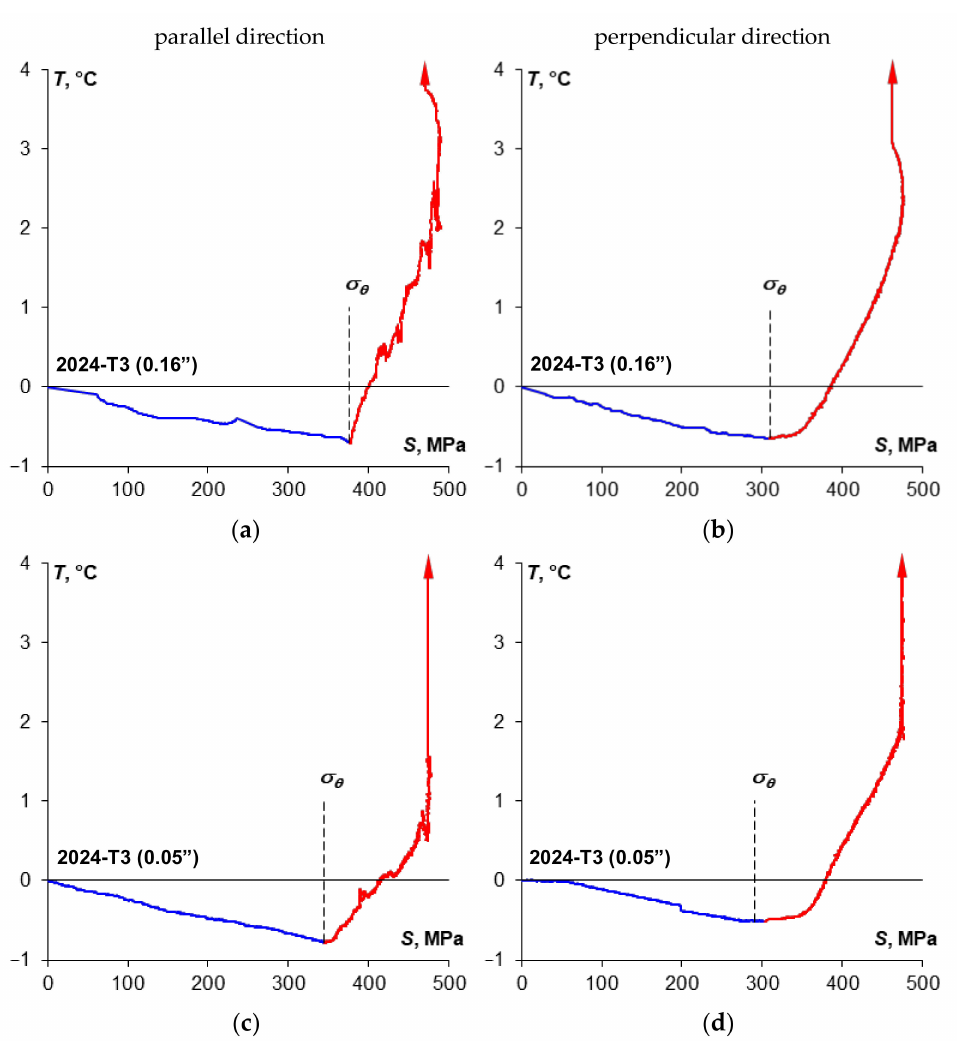
Figure 11. The summary of the temperature T and stress S change curves obtained during monotonic tensile tests of specimens made of 0.16” thick 2024-T3 sheet plate ( a , b ) and 0.05” thick 2024-T3 sheet plate ( c , d ) depending on the specimen cutting direction in relation to the sheet plate rolling